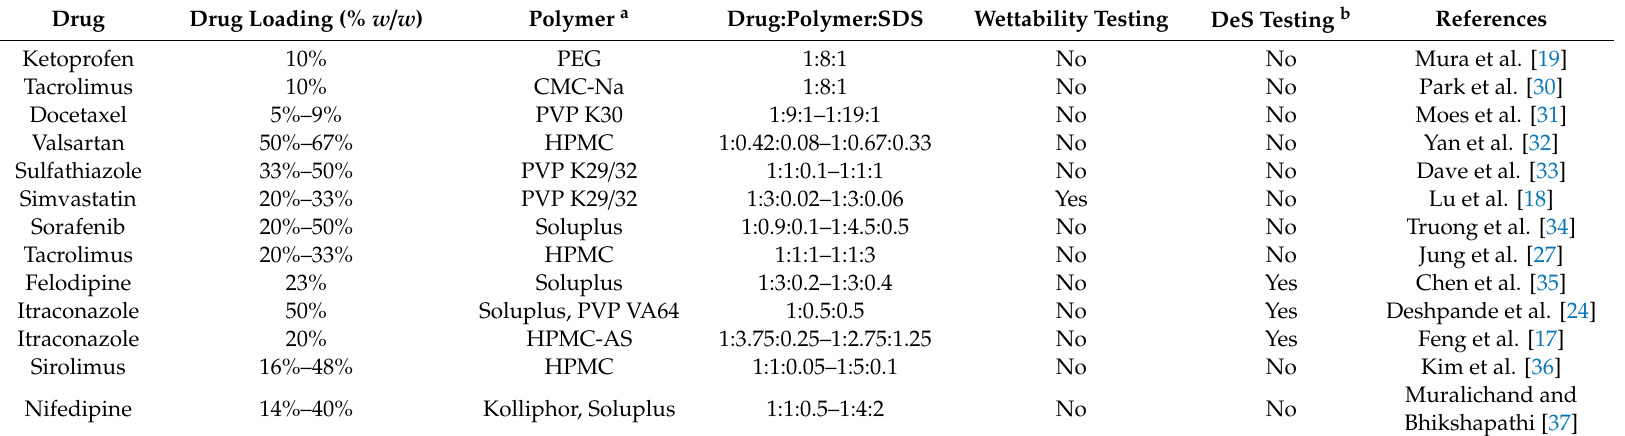
Table 1. Formulation composition of drug amorphous solid dispersion (ASDs) with sodium dodecyl sulfate (SDS) in various studies and survey of the use of wettability and desupersaturation